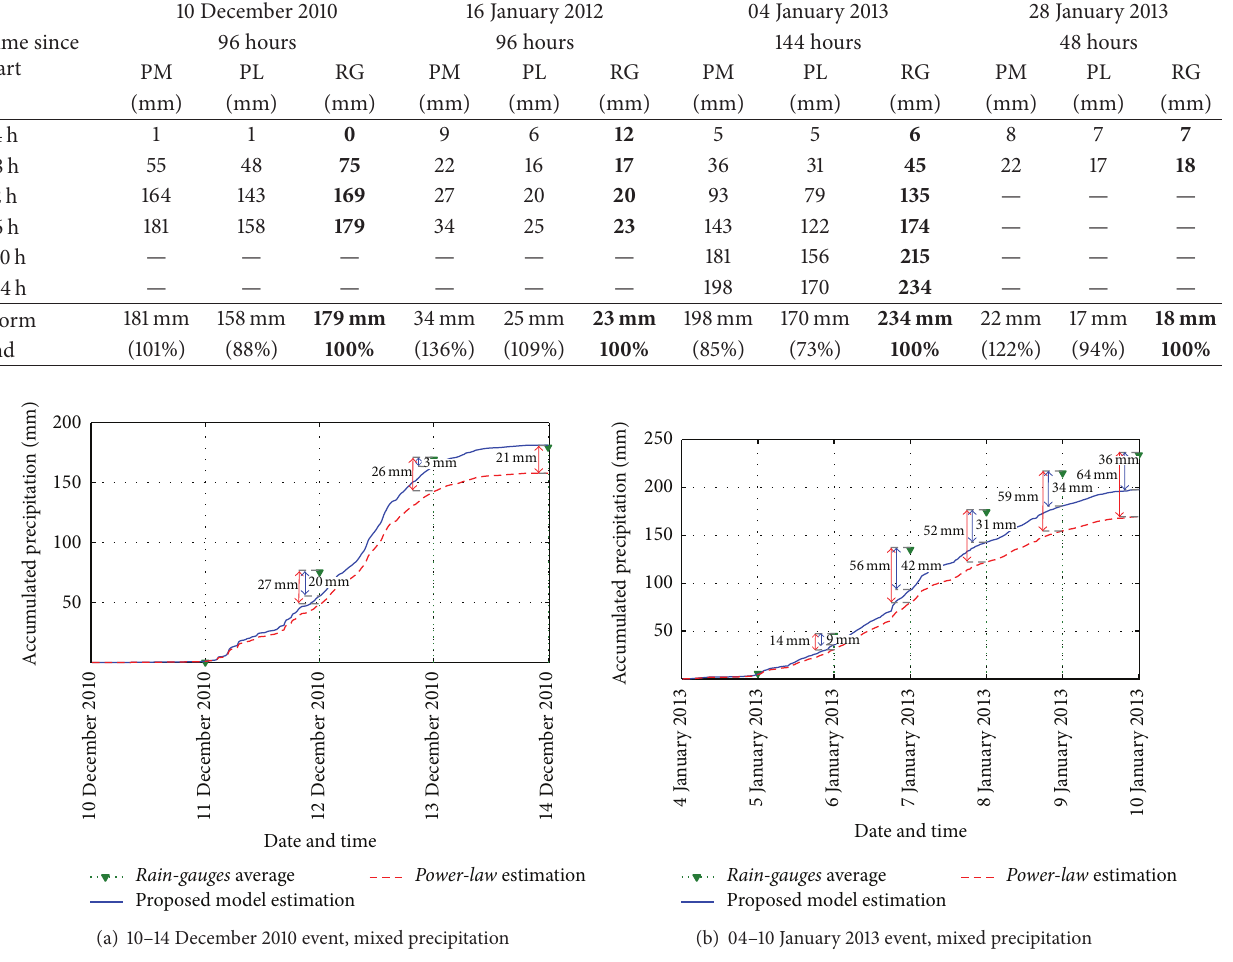
Figure 3: Accumulated precipitation between 10 December 2010 and 14 December 2010 (a) and the accumulated precipitation between 04 January 2013 and 10 January 2013 (b), as observed by the Rain-Gauges , as estimated by the proposed model, and as estimated by the Power- Law model. The estimates errors throughout the storms are presented: It can be seen, that the proposed model achieved better estimates throughout the